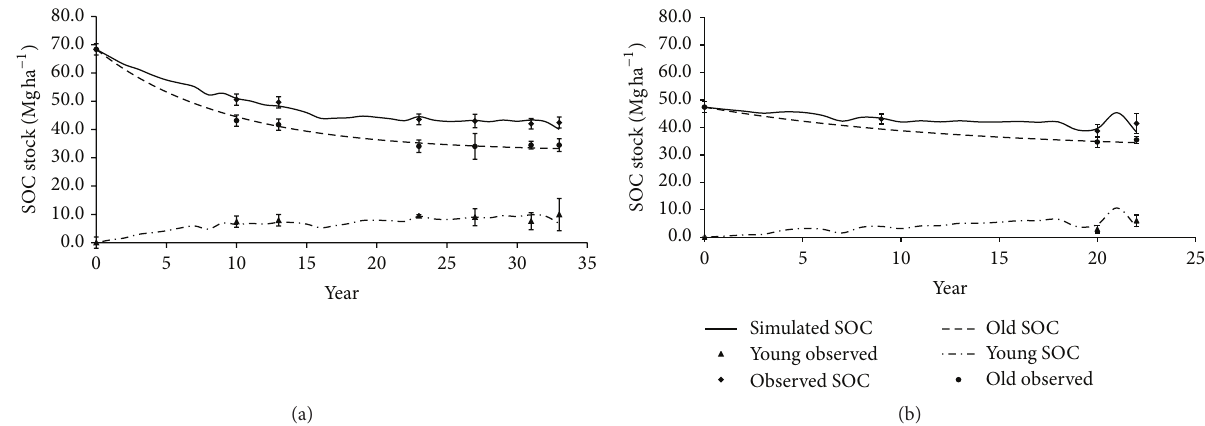
Figure 4: Observed and simulated total, young, and old carbon evolution in sites A (a) and B (b).